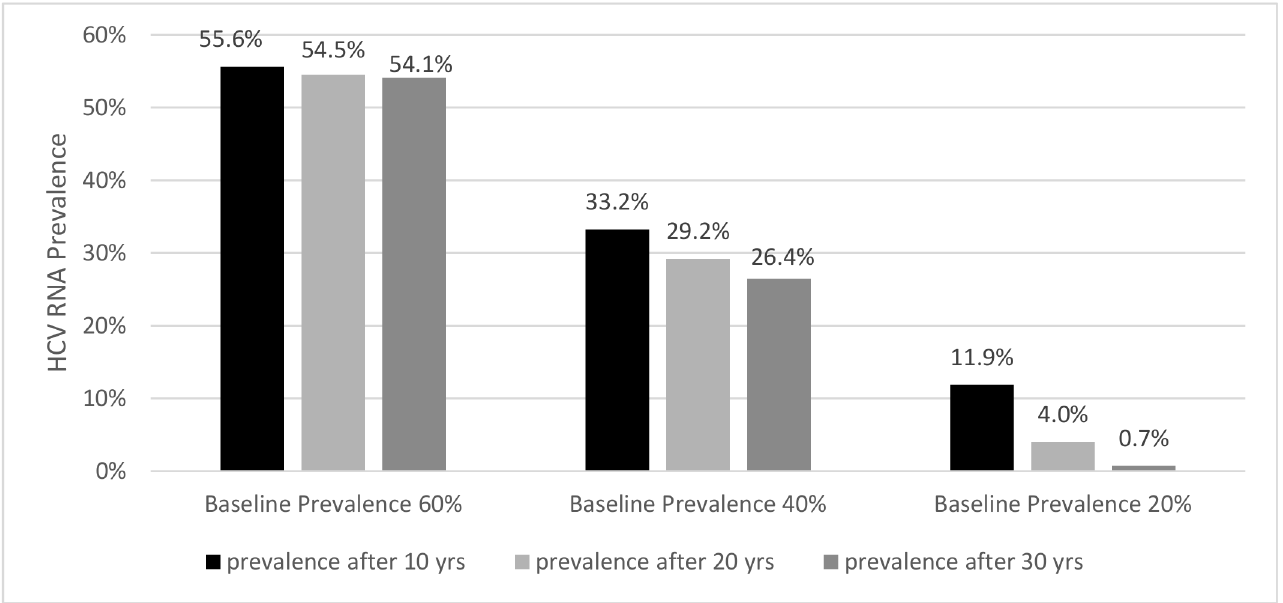
Fig 3. Effect of baseline HCV-RNA prevalence and differential duration of scale-up campaign (10, 20 and 30 years). Based on scale-up of 10 infection per 1000 PWID with a high proportion of cured infection (SVR 90%), a 12-week treatment duration, and acquired immunity ( ξ = 0.8).